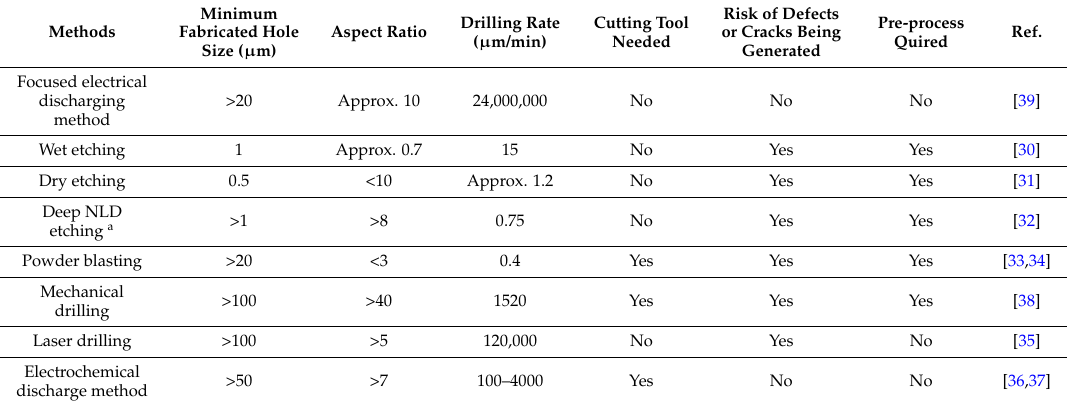
Table 1. Overview of the glass (micro)machining fabrication techniques and their general